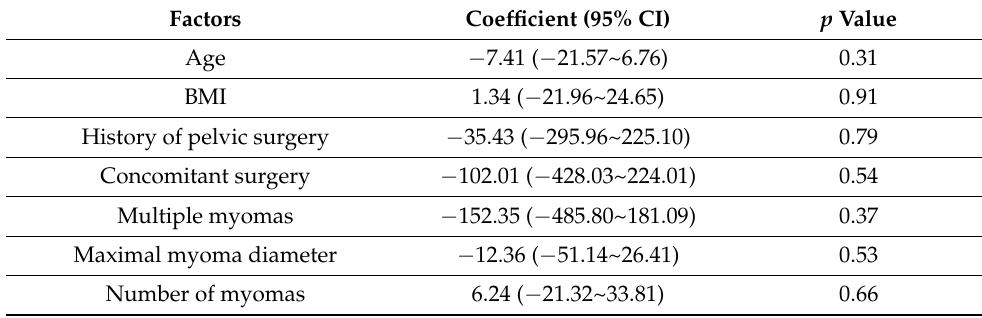
Table 3. Factors associated with estimated blood